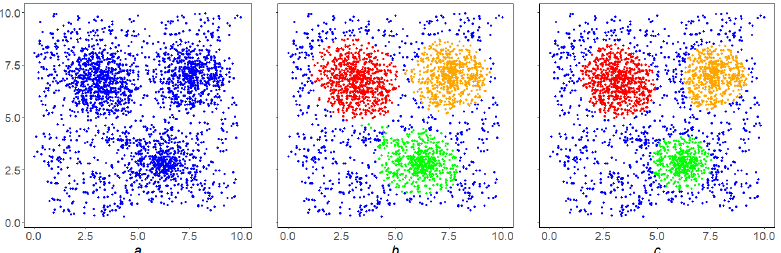
Figure 5. Application of the SDPS algorithm ( q = − 2, β = − 0.3, p = 0): ( a ) the original array; ( b ) the result of the first iteration X 1 ( − 0.3 ) containing isolated points; and ( c ) the final result of applying SDPS.